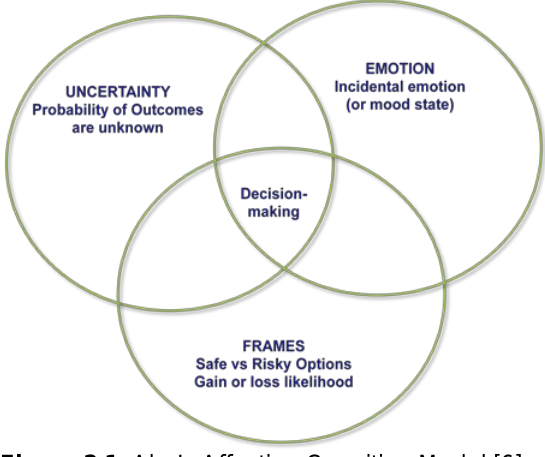
Figure 2.1. Ahn’s Affective-Cognition Model